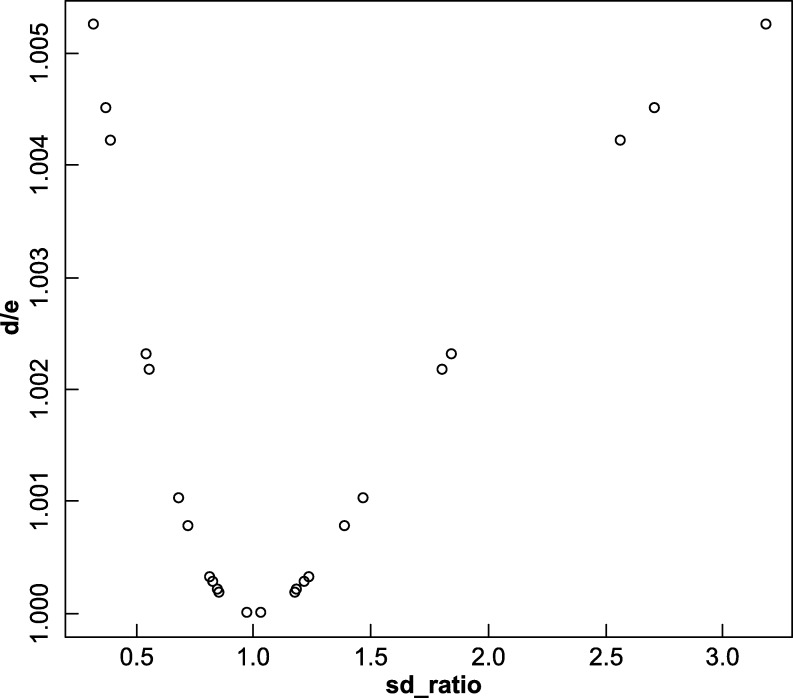
Plotted graph of Table 2.